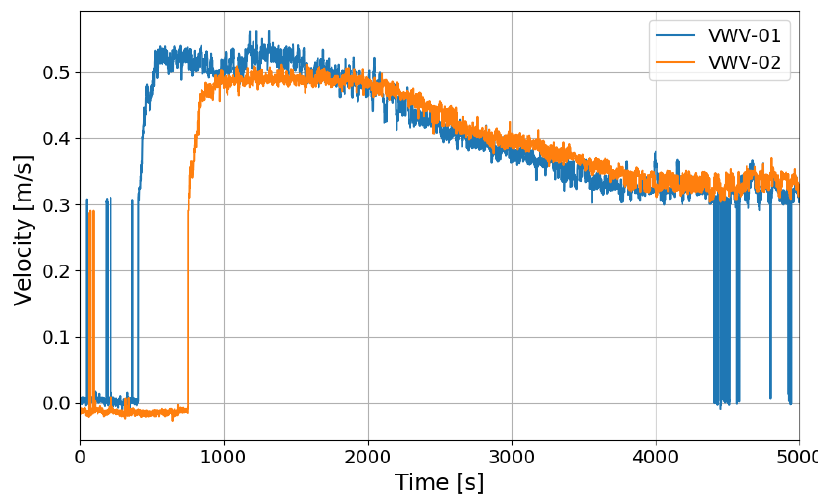
Figure 22. Gas velocities at the inlet of the PARs for the SP5 test, VWV-01: the right upper PAR, VWV-02: the left lower PAR.